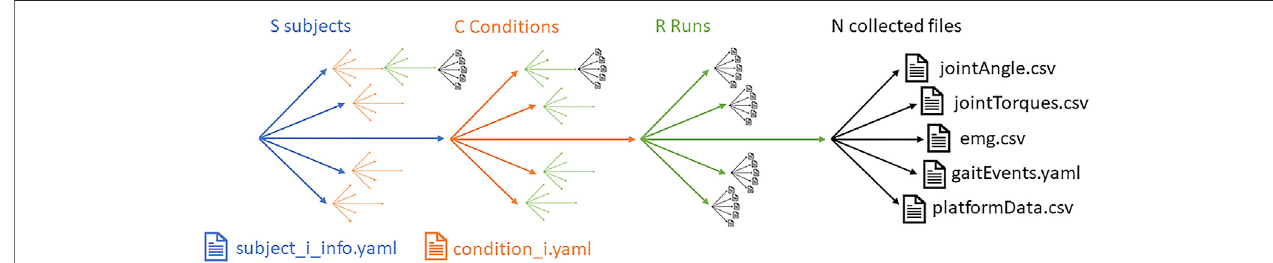
FIGURE 2 | Data collected during